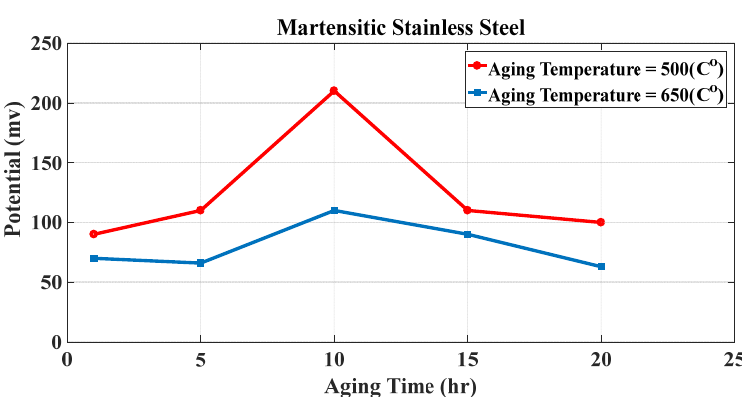
Fig. 15. Effect of aging time on voltage at two aging temperatures .